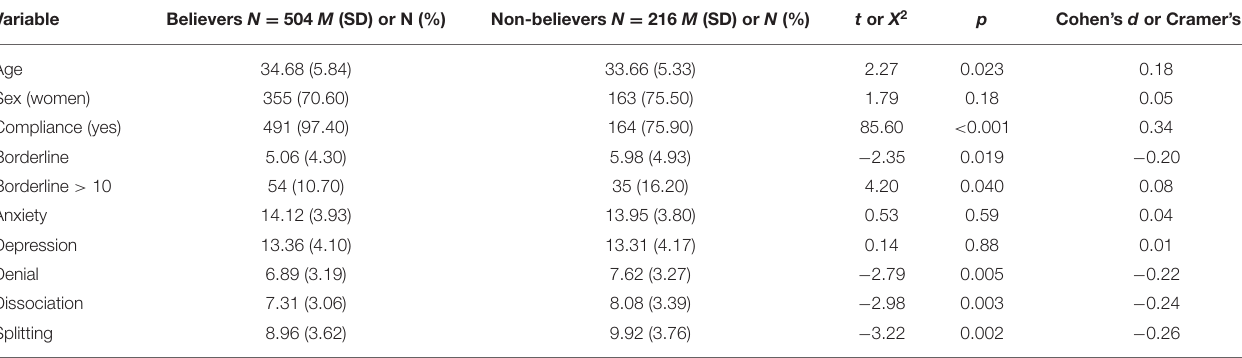
TABLE 1 | Demographic and psychometric characteristics of believers and non-believers; for numeric variables means and standard deviations in parenthesis with t -tests (or Welch tests) and Cohen’s d were presented and for dichotomous variables (sex, compliance, borderline > 10) number and percentage in parenthesis with X 2 test and Cramer’s V was presented.